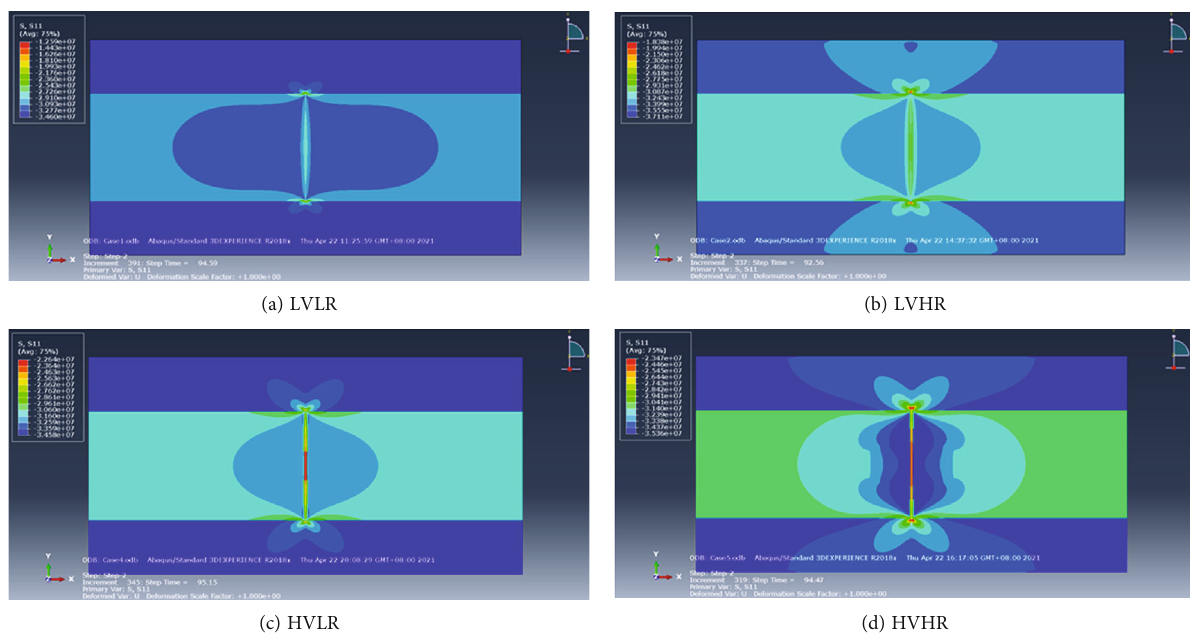
Figure 12: The in fl uence of fl uid viscosity and injection rates on height